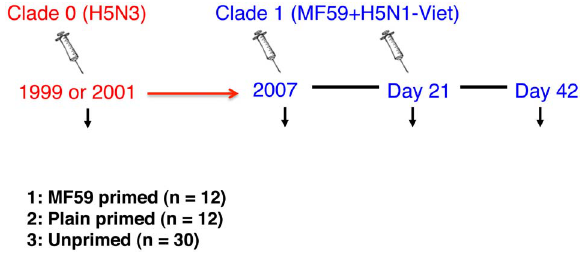
Figure 1. H5N1 prime-boost vaccine trial design. Schematic design of the heterologous H5N3 prime- H5N1boost vaccine immuni- zation is shown and was previously described [1]. The number of individuals in each group: Gp1=12; Gp2=12;